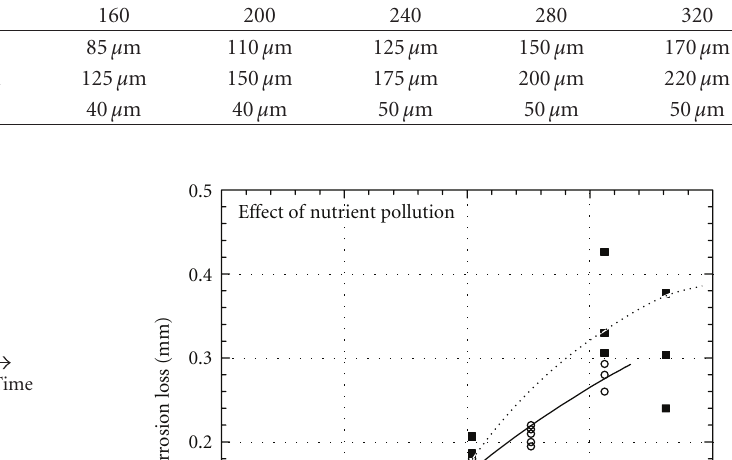
Figure 6: Corrosion model.